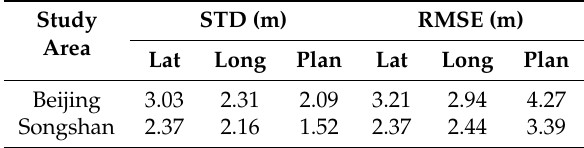
Figure 11. Plane error distribution of ( a ) Beijing and ( b ) Songshan areas. BA is the abbreviation of control point free block adjustment. Table 4. Error distribution after inherent error